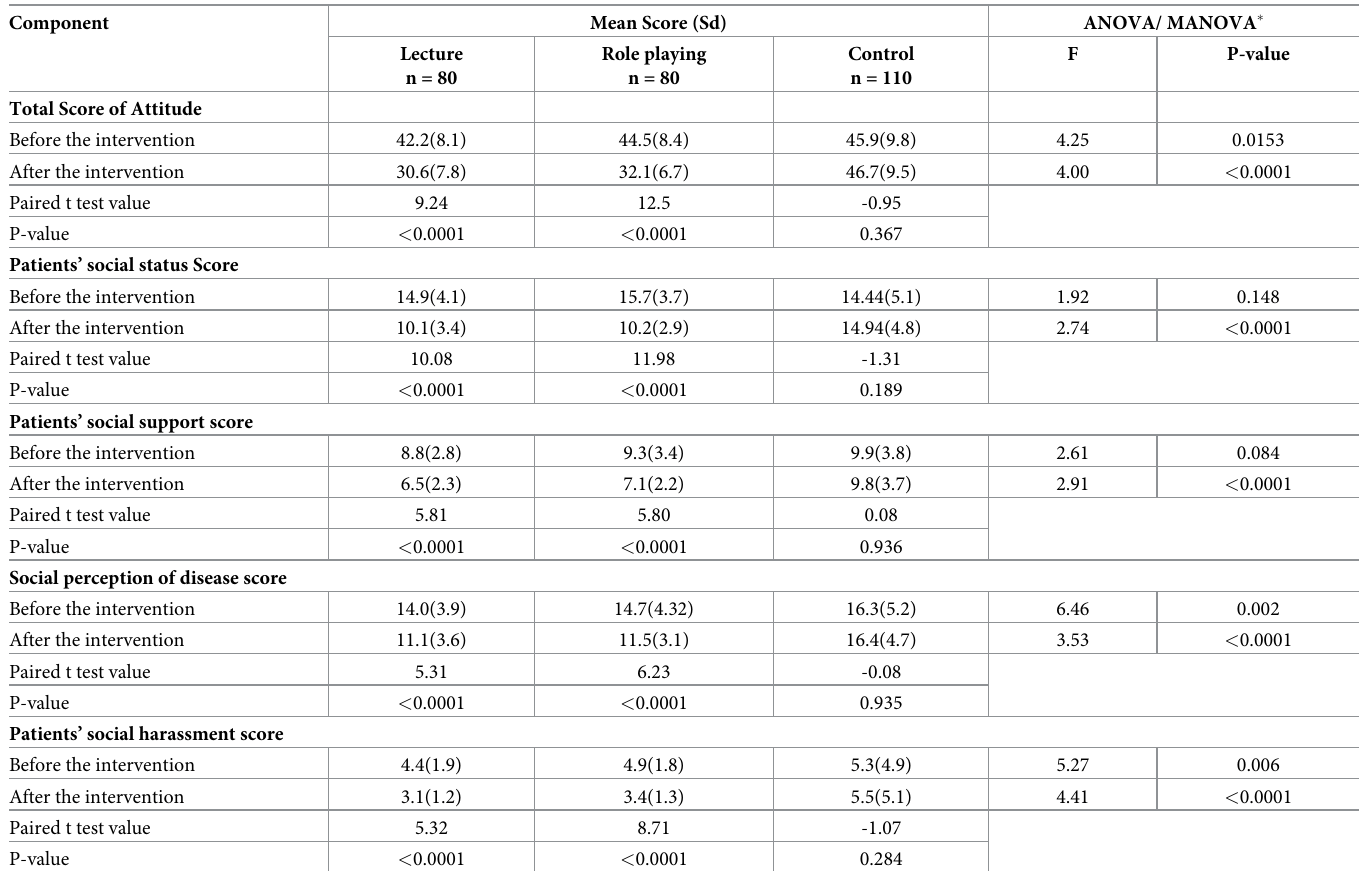
Table 3. Comparison of the attitude and its components between the groups before and after the